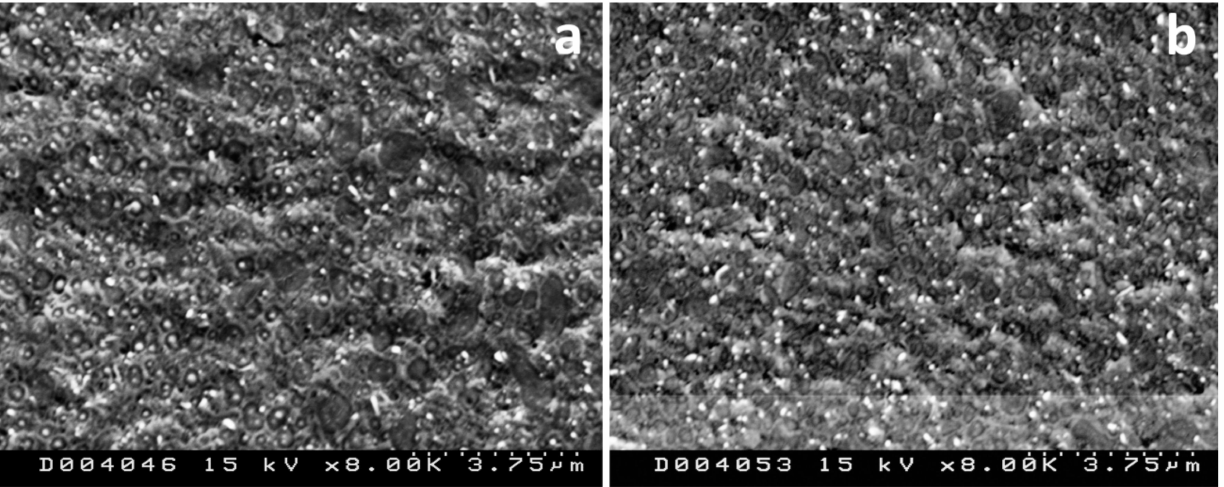
Figure 7. SEM micrographs of PA410/PA6/Pebax/CNT NCs: ( a ) 0.6% CNT; ( b ) 1%